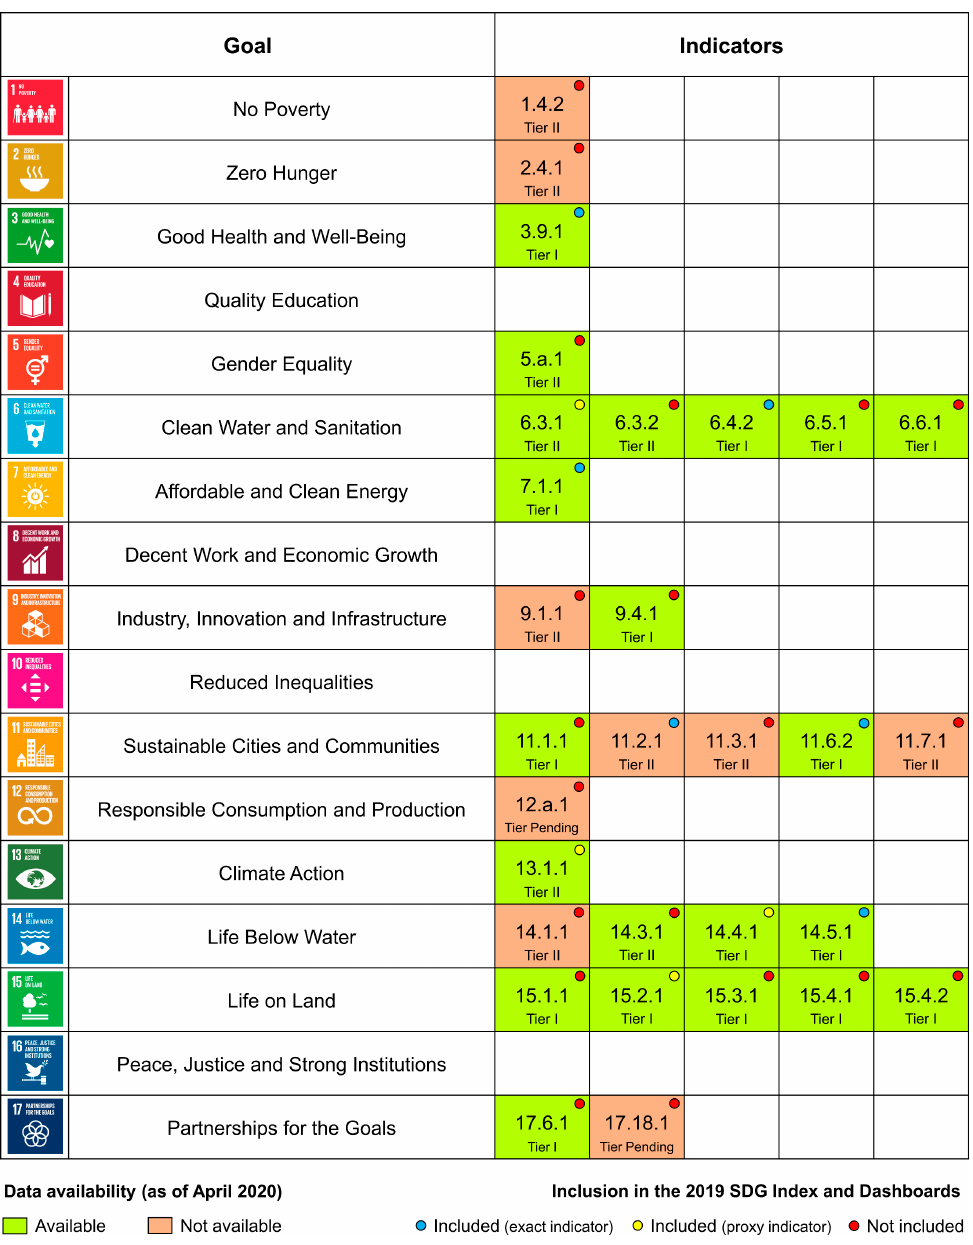
Figure 3. Current status of the RS-based SDG indicators. This list of indicators is based on GEO [25]. Data availability is based on the Global SDG Indicators Database as of April 2020 (https://unstats.un.org/sdgs/indicators/database/). The 2019 SDG Index and Dashboards are available in the Sustainable Development Report 2019 [97]. The tier classification of the indicators are those as of April 2020